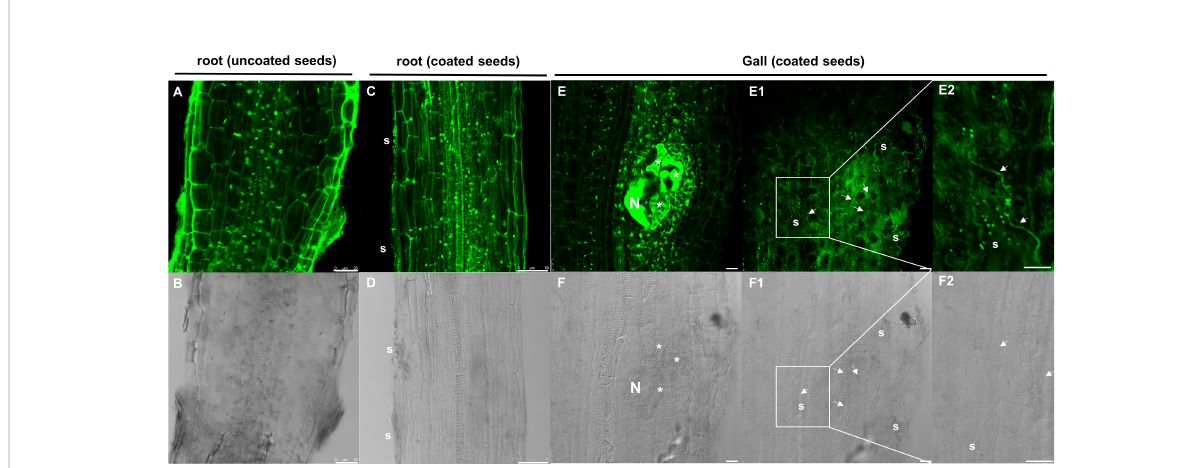
FIGURE 6 Representative images of auto- fl uorescence (in green) and transmittance light (in grey) of bacteria in the tomato root external tissue and inside the galls. (A, B) , tomato uncoated root control. (C, D) tomato root coated with dual-strain bacteria combination. (E, F) , 14dpi gall of tomato root coated with dual-strain bacteria combination. E1 , F1 ) upper part of a z-stack of the 14dpi gall of tomato root coated with dual-strain bacteria combination shown in E, F , E2 , F2 ) close up images of E1 and F1, respectively. Data showed that tomato roots and galls/giant cells coated with the dual-strain bacteria combination of B paralicheniformis FMCH001 and B subtilis FMCH002 were colonized by spores (s) and/or vegetative cells. Asterisks, giant cells; N, nematode; white arrows, vegetative cells; s, spores. Scale bars: 25µm for A, B, E, E1, E2, F, F1 and F2 . 50µm for (C) and (D) Seeds were uncoated (black) or coated (grey) with the dual-strain bacteria combination of B paralicheniformis FMCH001 and B subtilis